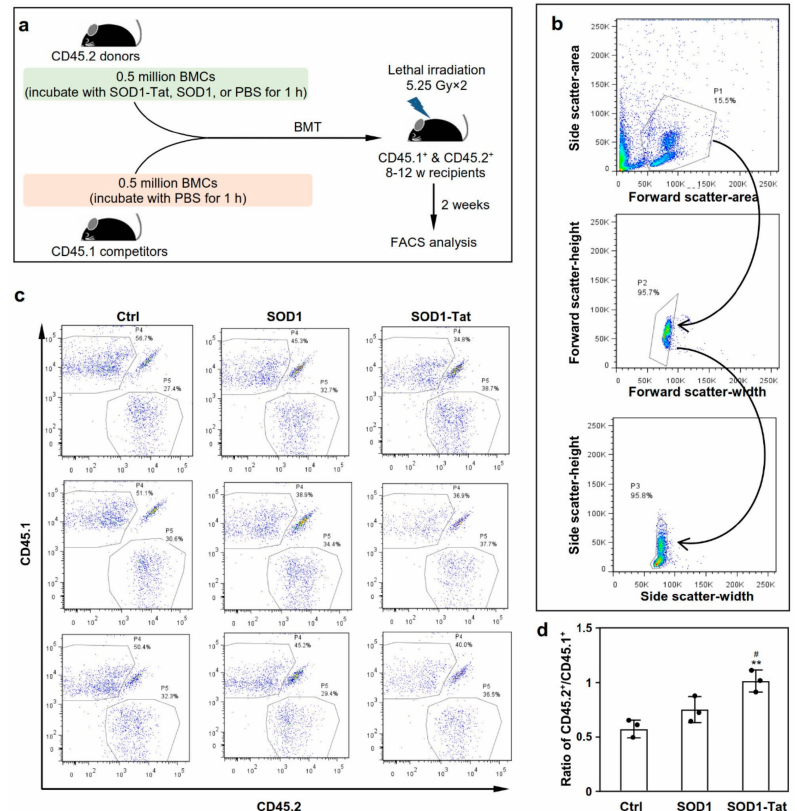
Figure 3. SOD1-Tat increases the total bone marrow engraftment capacity. ( a ). The experimental flow chart of competitive transplantation. After treatment with recombinant SOD1-Tat, SOD1, or PBS as a control, half a million CD45.2 BMCs were used to compete against an equal number of CD45.1 BMCs to reconstitute the hematopoietic compartment of a lethally irradiated recipient mouse (CD45.1 + & CD45.2 + ). Two weeks after transplantation, peripheral blood samples were collected retro-orbitally from the transplanted recipient mice for FACS analysis. ( b ). Living cell populations selected by gating on the physical characteristics of peripheral white blood cells. After two steps of selection according to cellular characteristics, population 3 was finally selected for FACS analysis. Cell clusters, cell debris, and other non-cell particles were excluded from the subsequent hematopoietic chimerism analysis. ( c ). FACS plots showing the percentage of CD45.1 + (P4) and CD45.2 + (P5) donor-derived WBCs in the peripheral blood two weeks after transplantation. The results represent three independent biological repeats ( n = 3). ( d ). Ratio of CD45.2 + (P4) to CD45.1 + (P5) donor-derived WBCs. Results were presented as mean ± SD, n = 3. #: p < 0.05; **: p < 0.01, versus the control